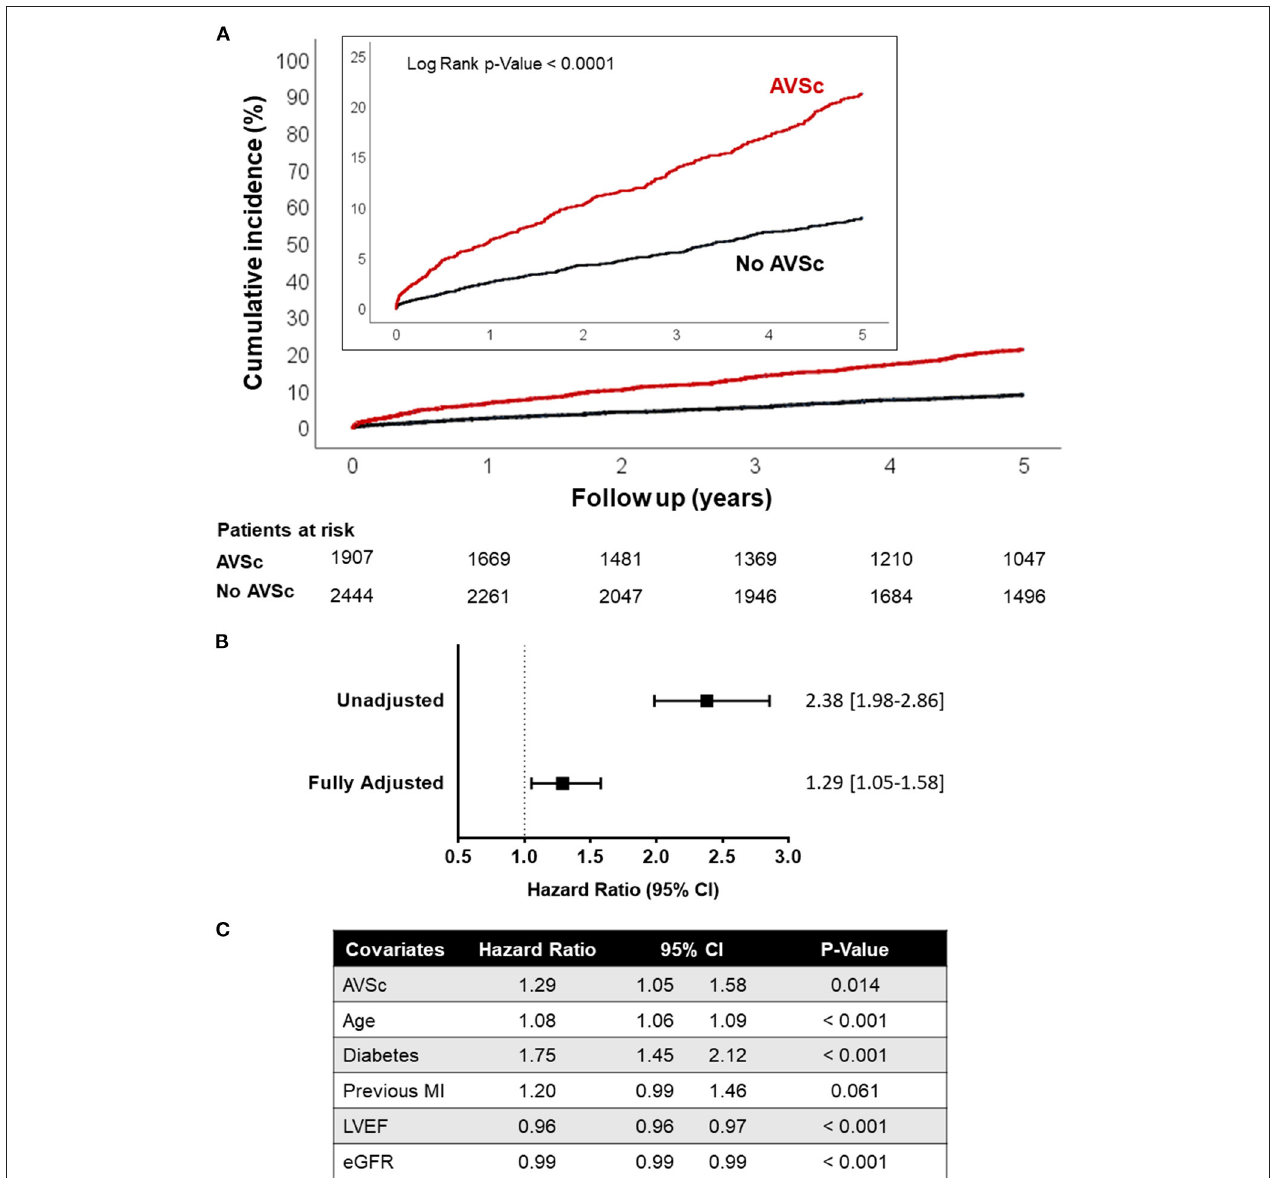
FIGURE 4 | Long-term all-cause mortality in high-risk CAD patients. (A) Kaplan-Meier curves showing the cumulative incidence of all-cause mortality in high-risk CAD patients with AVSc vs. high-risk CAD patients without AVSc. (B) Cox-regression analyses showing the hazard ratios (HR) unadjusted and fully adjusted for age, diabetes mellitus, previous MI, LVEF, and eGFR. Square brackets indicate the 95% confidence interval. (C) Table showing the HR associated with all covariates considered in the fully adjusted model. AVSc, aortic valve sclerosis; CAD, coronary artery disease; eGFR, estimated glomerular filtration rate; LVEF, left ventricular ejection fraction; MI, myocardial